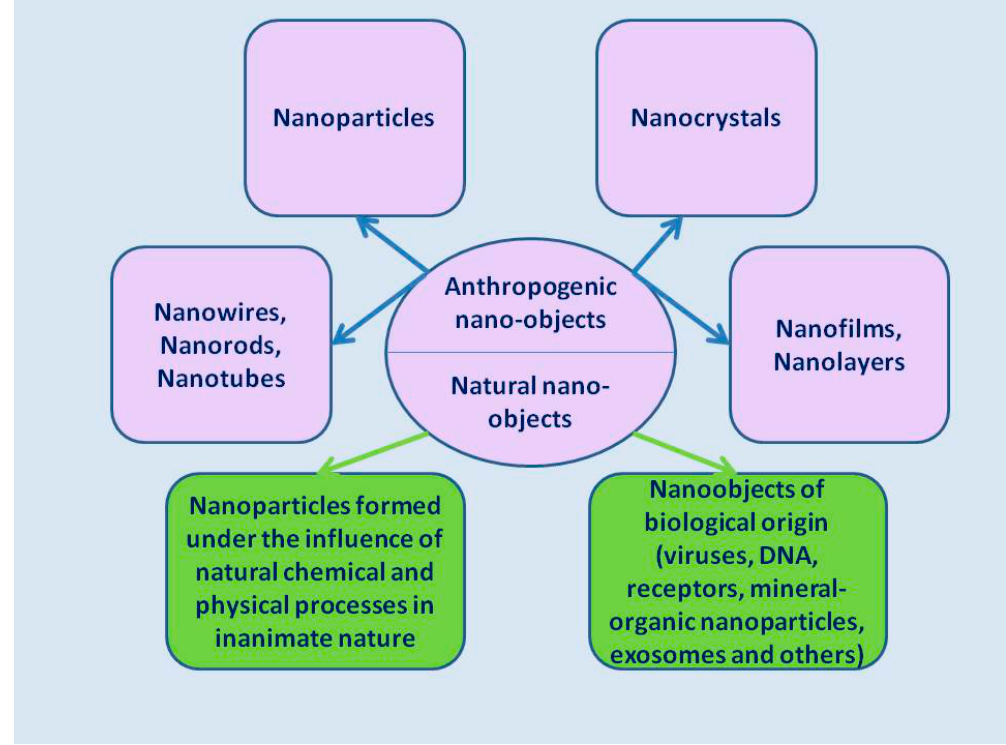
Figure 1. The main types of anthropogenic and natural nano-objects.